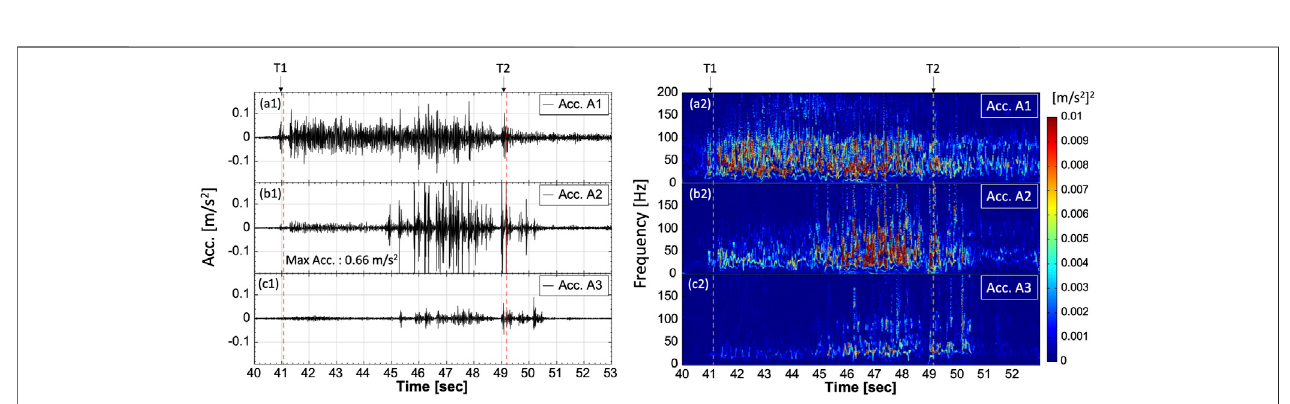
FIGURE10| Seismicsignalsandtheircorrespondingtime – frequencyspectraoftherockmixturefalltest(Test7).T1:41.0 s,rockmixturesimpactingontheslope; T2: 49.1 s, the rocks impacting on the creek bed.